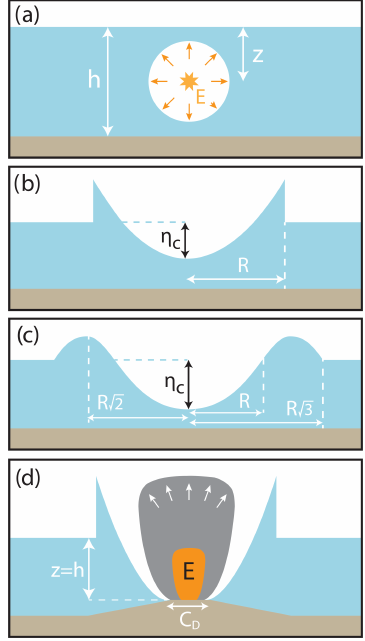
Figure 1. Illustrations of the subaqueous explosion problem. (a) An explosion of yield E at depth z in water of depth h . (b) The initial surface elevation profile is given by Eq. (1). (c) The initial surface elevation profile is given by Eq. (2). (d) Schematic of a volcanic scenario in which such an explosion would occur at maximum depth where z = h , and crater diameter C D can be measured or calculated using estimated ejecta volume V with Eqs.